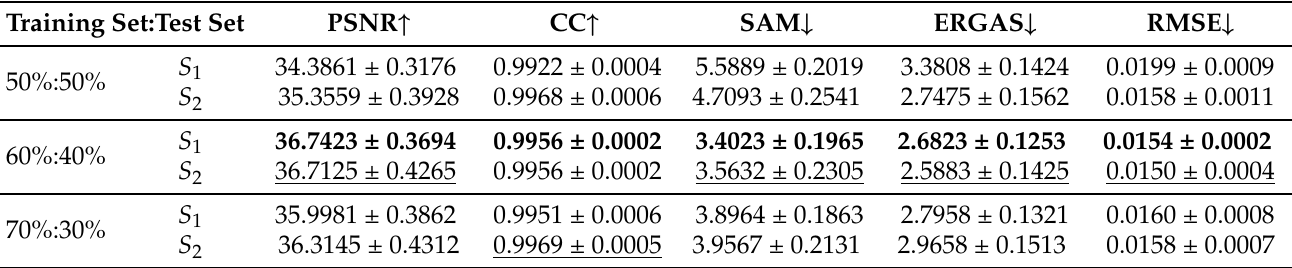
Figure 4. ( a ) Loss function curves of the SeAM ( S 1 ) of the SSML framework and the original SeAM during 5000 iterations of training; ( b ) the difference curve between the loss values of the original SeAM and the SeAM ( S 1 ) in the SSML framework during 5000 training iterations. Table 5. Experimental results of different proportions of training